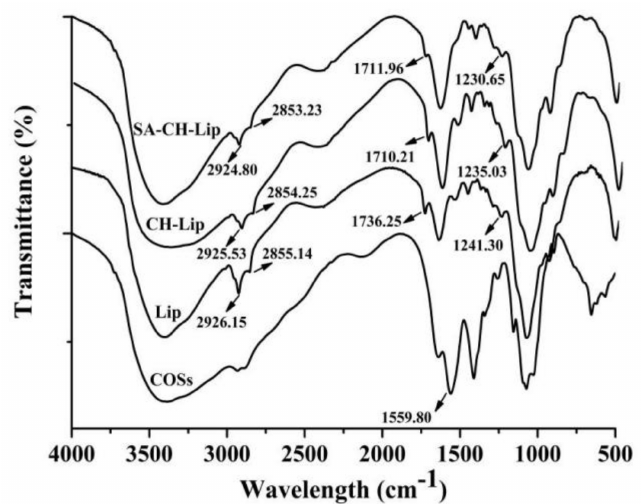
Figure 5. Fourier transform infrared (FTIR) spectra of COSs and COSs